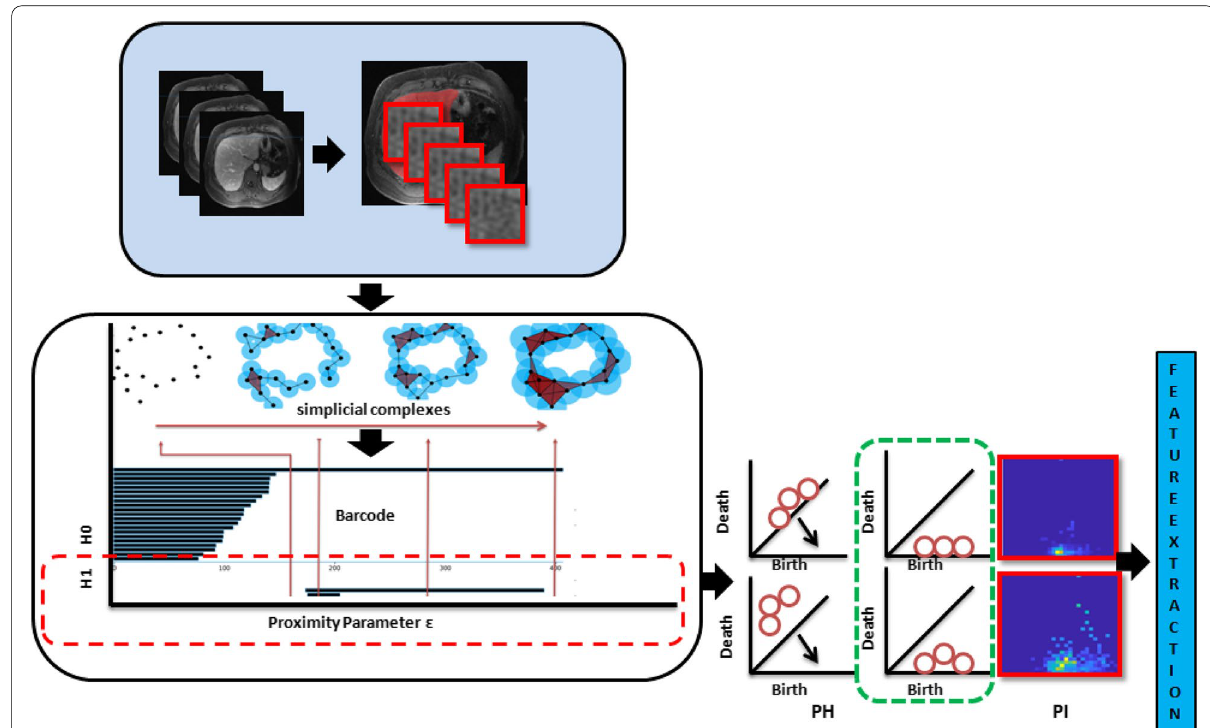
Fig. 1 Workflow of algebraic topology-based machine learning with imaging signal as